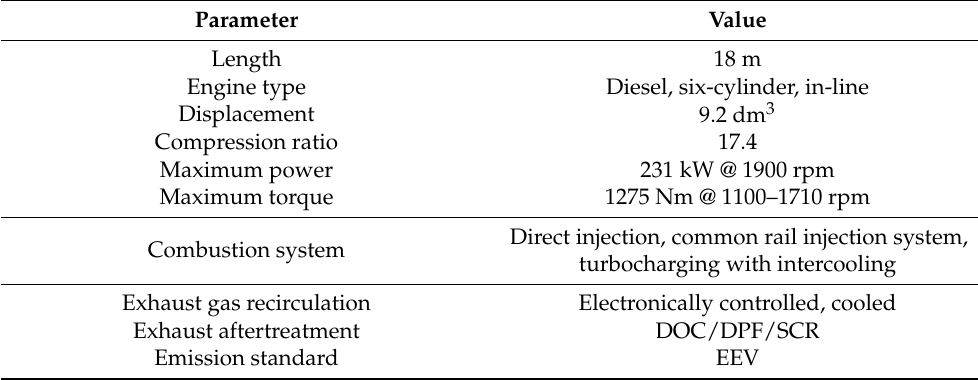
Figure 5. A view of the measuring apparatus during the tests. Table 8. Specifications of the conventional city bus used in the